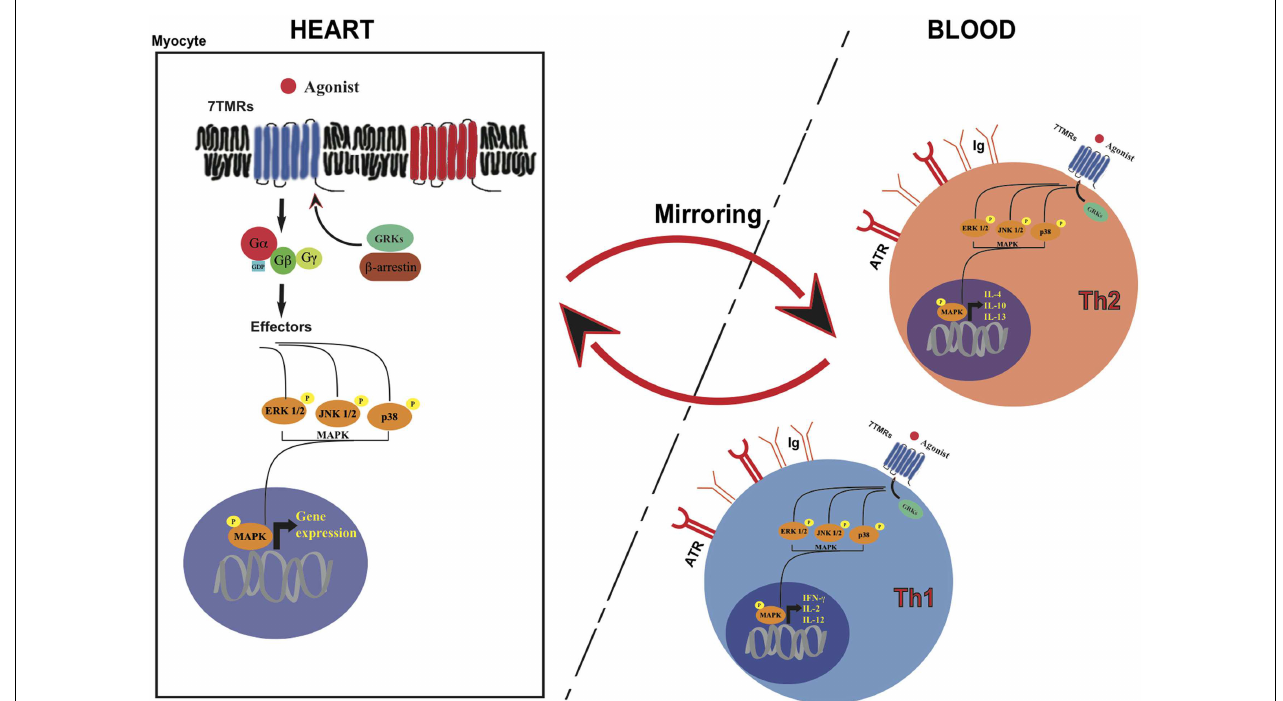
FIGURE 1 |The “paradigm” of lymphocyte mirroring of heart signals